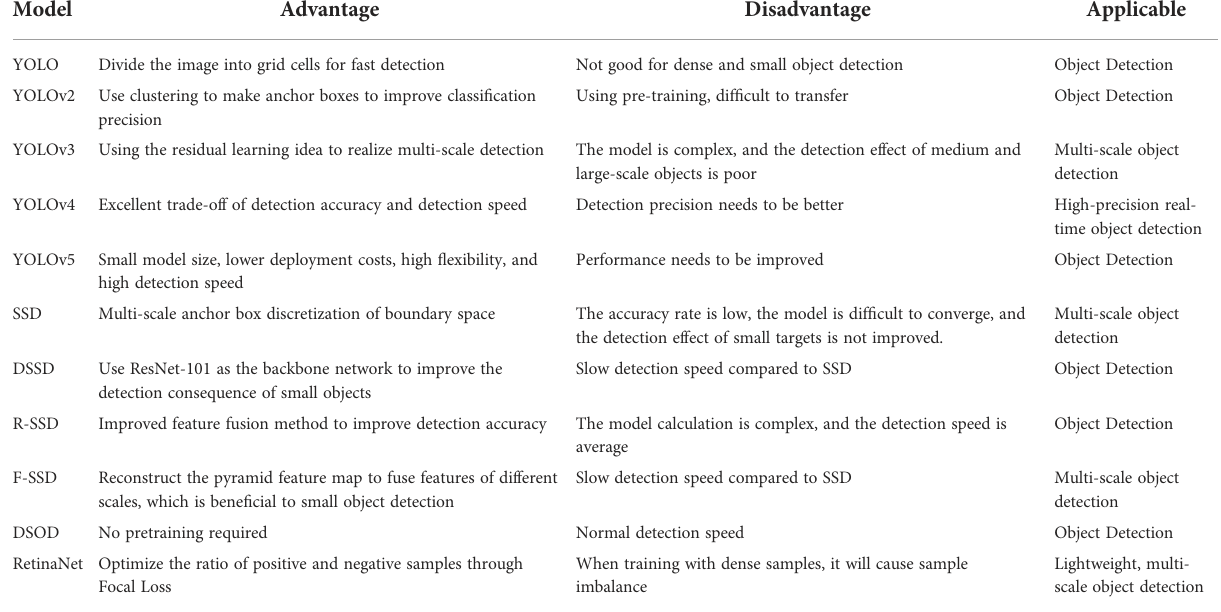
TABLE 3 Advantages, disadvantages, and applicable situations of single-stage Object detection algorithms.